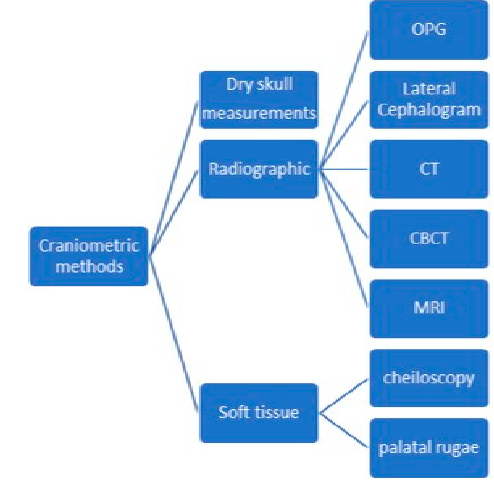
Figure 5. Types of craniometric methods.